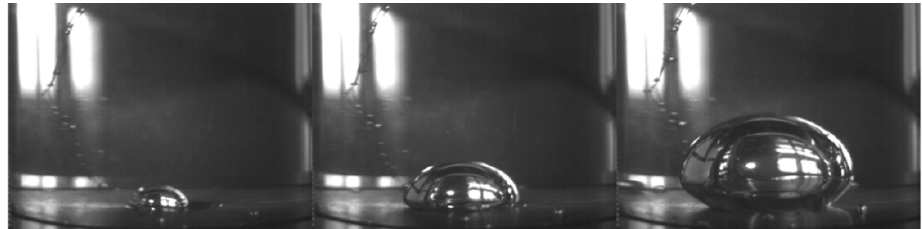
Figure 5. The growth and departure behavior of an isolated bubble under LAP.